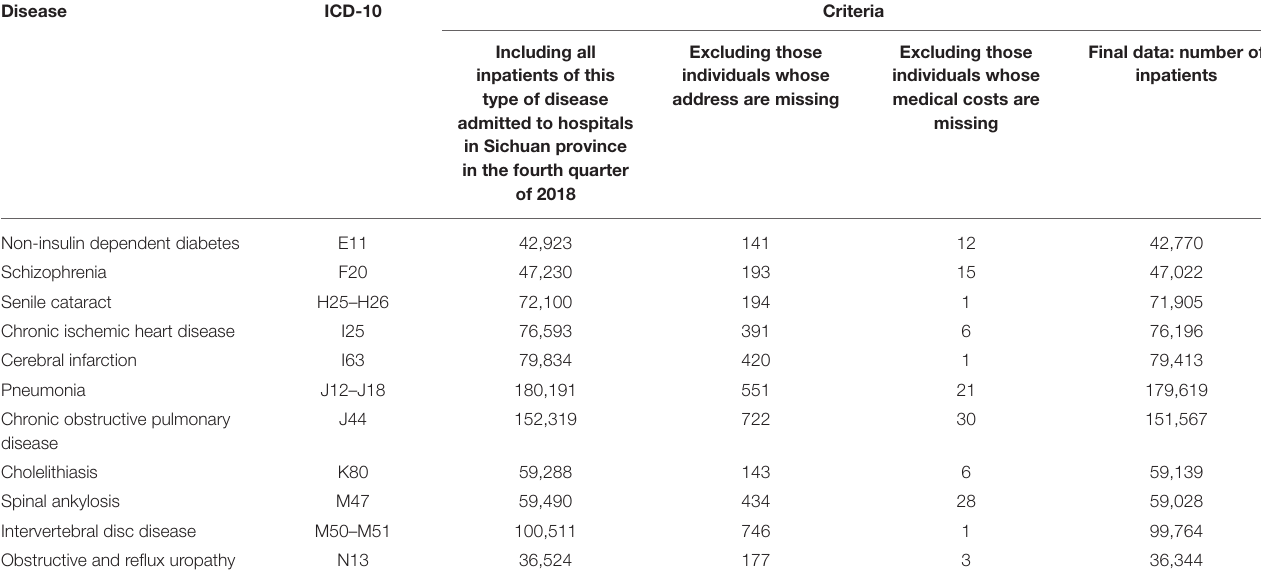
TABLE 2 | The details of disease selection and data cleaning.